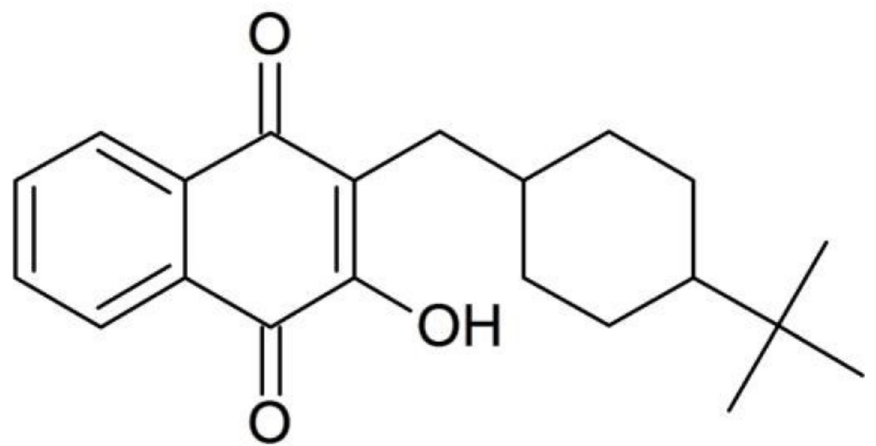
Fig 1. Chemical structure of